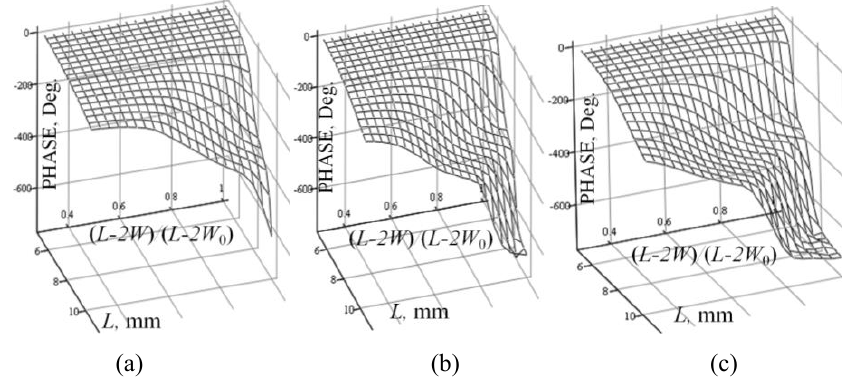
Fig. 3. Reflection-coefficient phase dependence on L and the slot width for two-layer square-loop slots. The slot width is recalculated in ( L-2W ) / ( L-2W 0 ) ratio where W 0 =1 mm. Frequencies are: (a) 14 GHz; (b) 16 GHz; (c) 18 GHz.